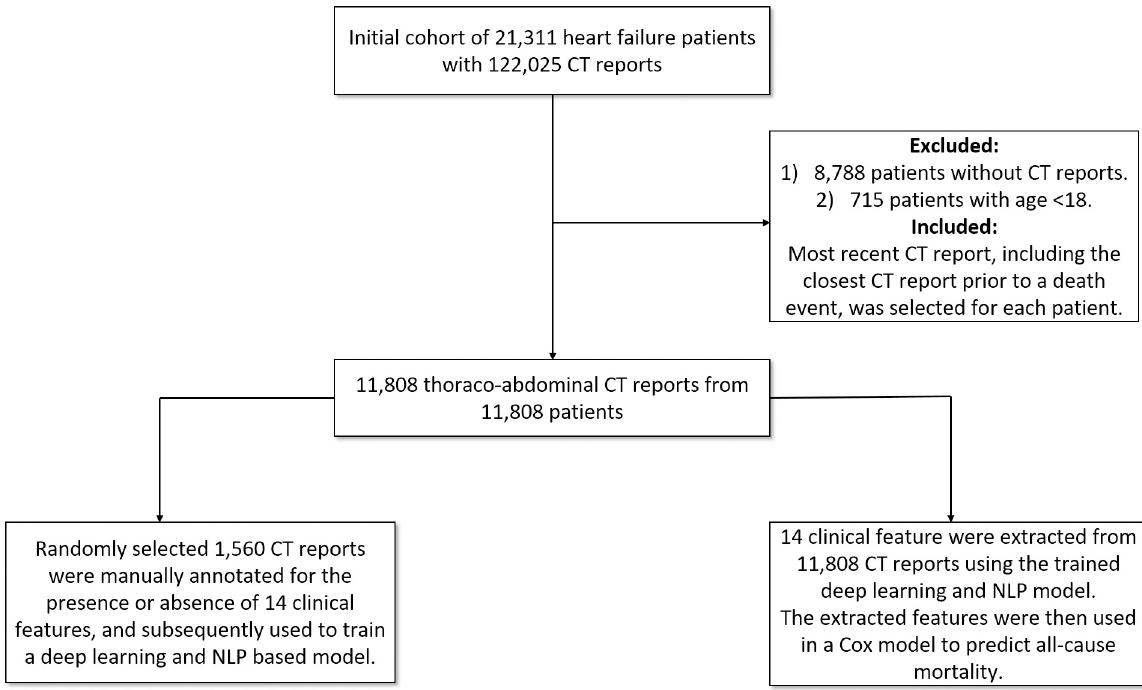
Fig 1. Overall study design and workflow. 11,808 thoracoabdominal CT reports from 11,808 patients were included in the final analysis.